Question: Briefly state, in one sentence, what is plotted here.
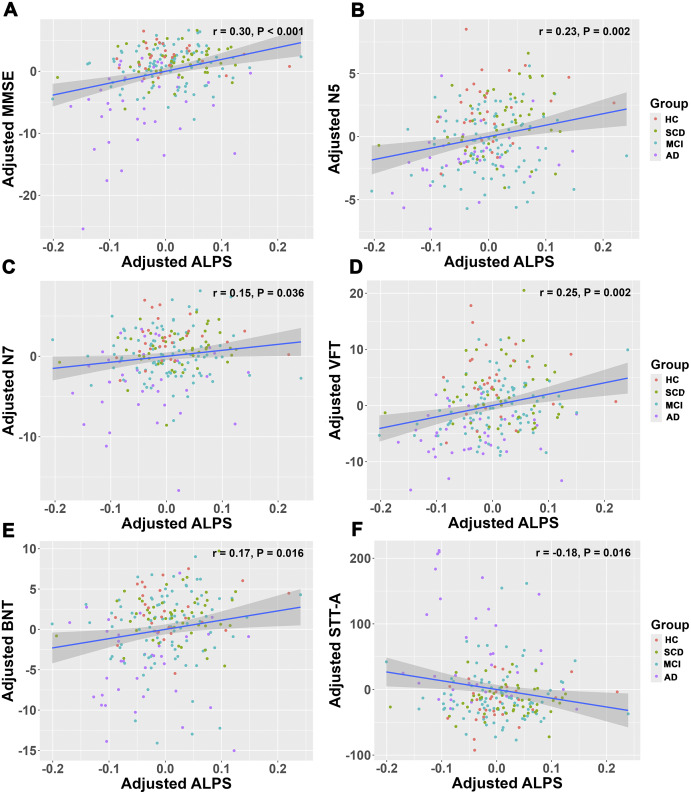
Answer: Association between ALPS and cognitive function (regressed for gender, age, education level, and APOE4). After adjusting for gender, age, education level, and APOE4 carrier status, ALPS was positively correlated with MMSE ( r = 0.30, P < 0.001), as well as with N5 and N7 ( r = 0.23, P = 0.002; r = 0.15, P = 0.036). It was also positively correlated with VFT and BNT scores ( r = 0.25, P = 0.002; r = 0.17, P = 0.016), and negatively correlated with STT-A scores ( r = −0.18, P = 0.016). Note: ALPS, ‘Analysis of diffusion tensor imaging along the perivascular space’; HC, ‘Healthy Controls’; SCD, ‘Subjective Cognitive Decline’; MCI, ‘Mild Cognitive Impairment’; AD, ‘Alzheimer’s Disease’; MMSE, ‘Mini-Mental State Examination’; VFT, ‘verbal fluency test’; BNT, ‘Boston naming test’; STT-A, ‘Shape Trail Test A’. Figure 2. long description.